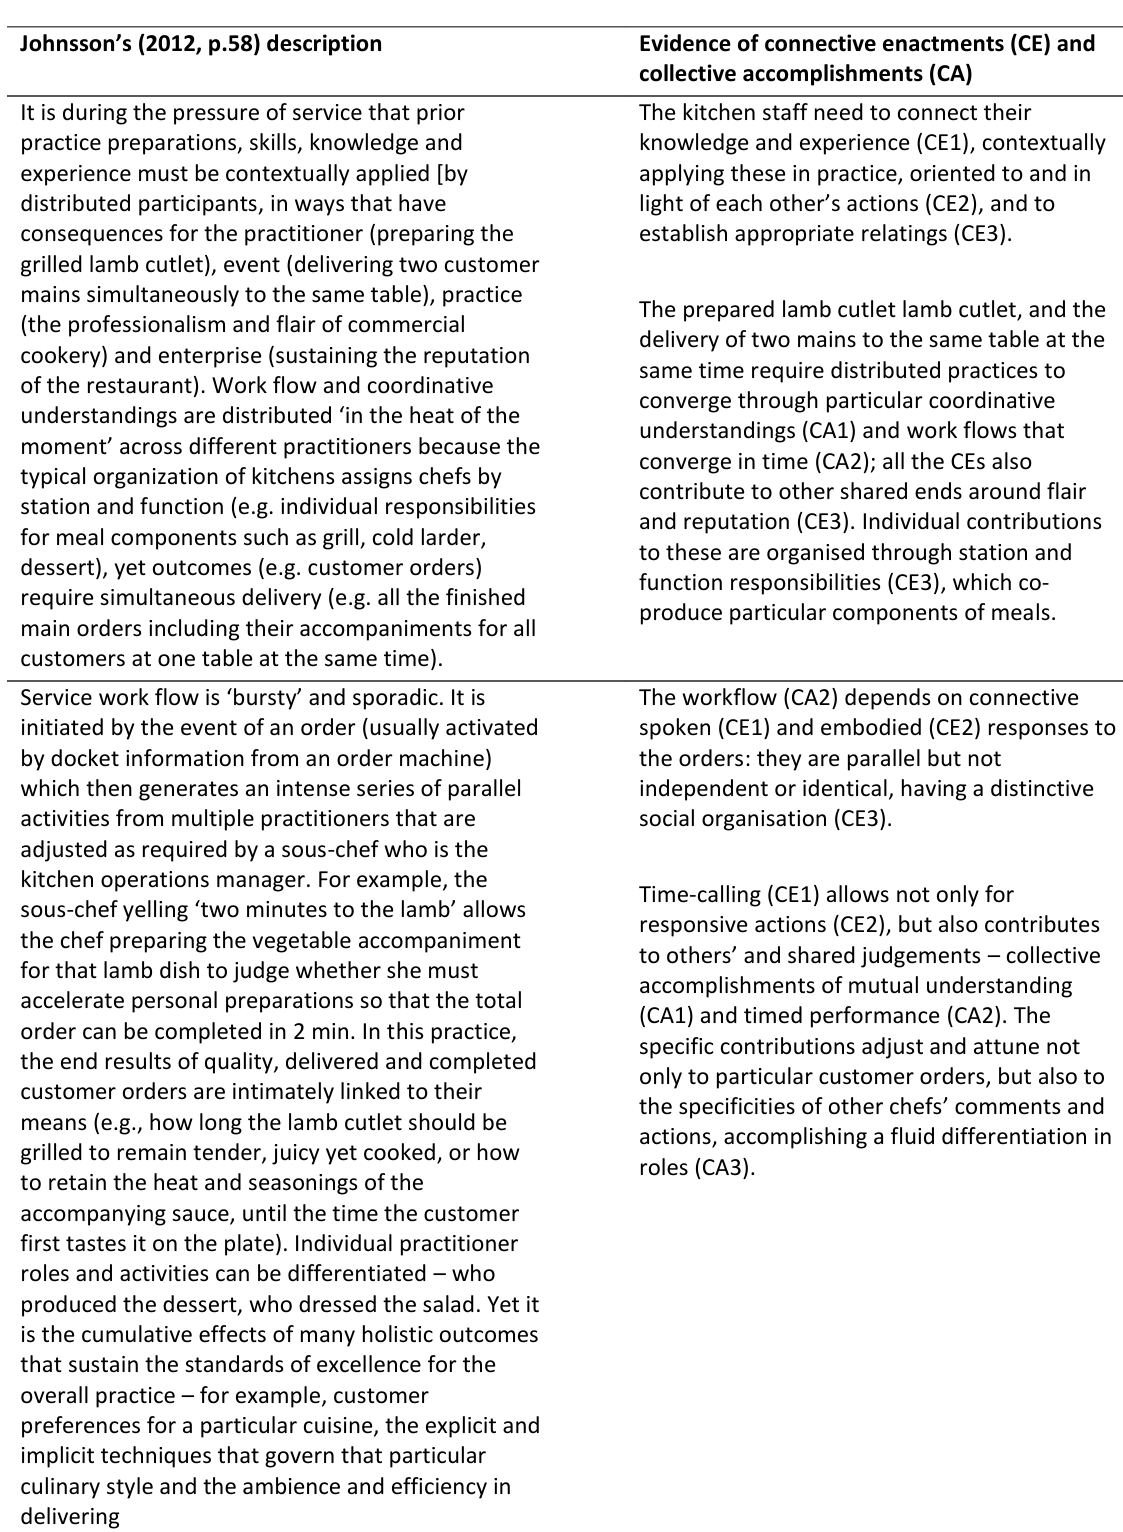
Table 2. Connective enactment and collective accomplishment in a culinary services